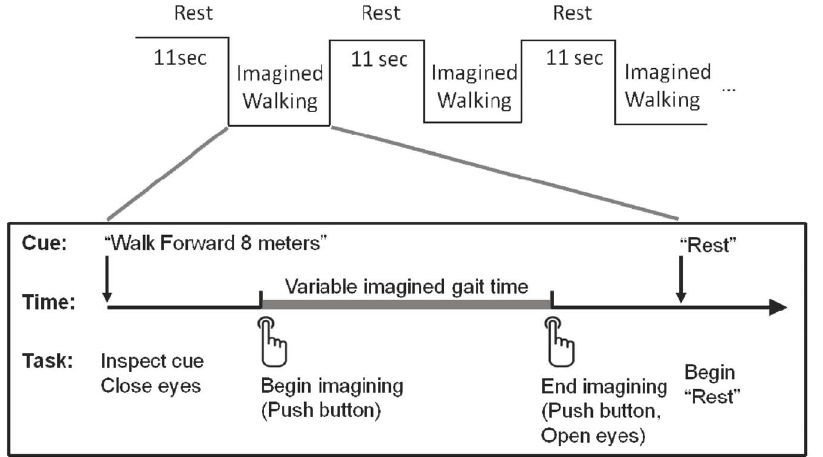
Figure 1. Gait imagery task. After reading the cue, the participant closes his eyes, pushes a button, and begins imagining. At the completion of gait imagery, he again presses the button and opens his eyes.